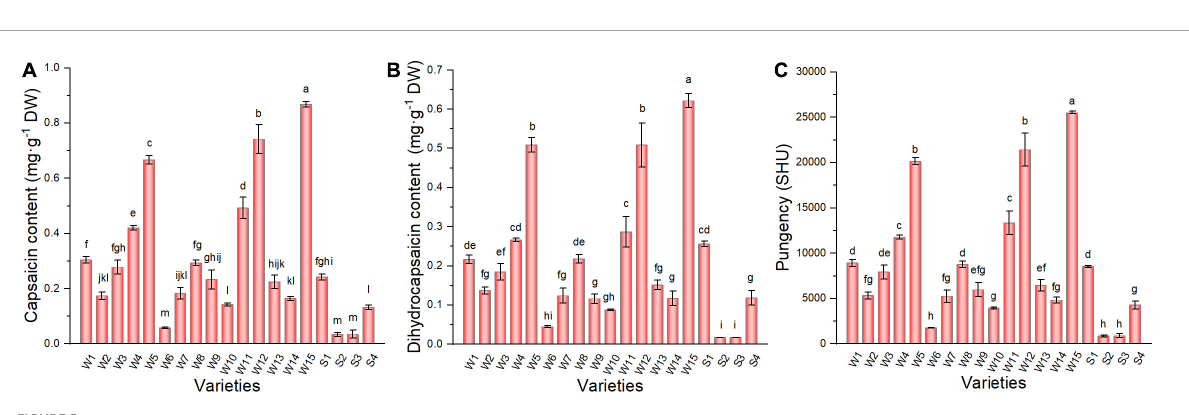
FIGURE5 The capsaicin content (A) , dihydrocapsaicin content (B) , and pungency (C) of pepper fruits. Data are presented as mean ± SE. Different lowercase letters indicate statistical significance according to Duncan’s multiple range test ( p < 0.05). W1, Fengshouxianjiao; W2, Sujiao 8; W3, Qingan 7; W4, Sujiao 18; W5, Longjiao 2; W6, Longjiao 10; W7, Longjiao 11; W8, Huamei 105; W9, 37–124; W10, 3F*106; W11, Tianjiao 20; W12, Tianjiao 23; W13, Hangjiao 2; W14, Hangjiao 8; W15, NO.171; S1, NO.212; S2, NO.221; S3, Sujiao 9; S4,